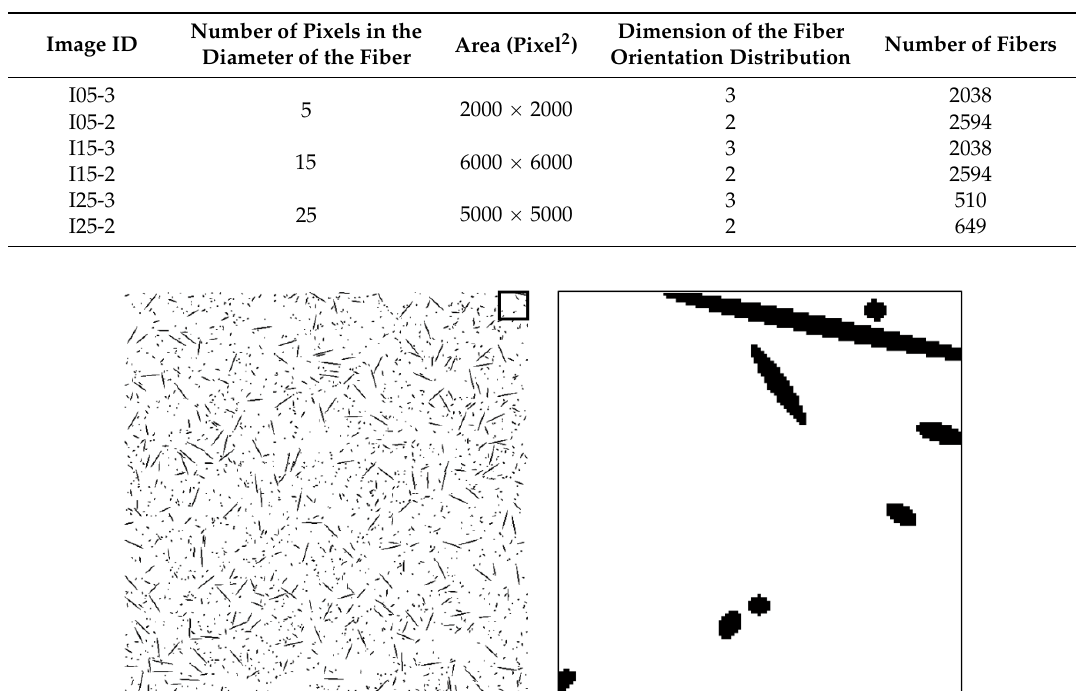
Table 4. Images to assess the performance of the proposed technique.